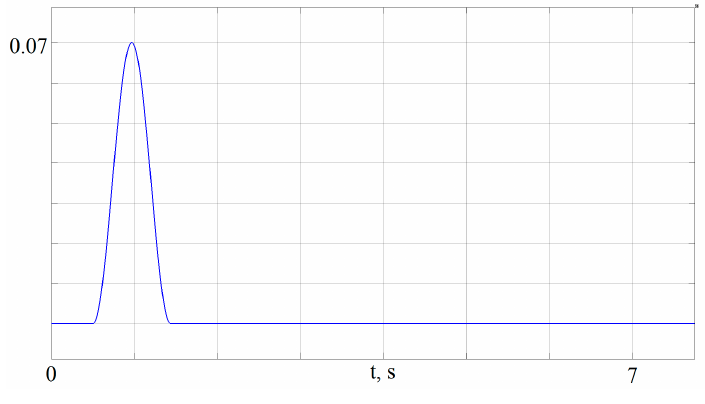
Figure 16. Road bump.